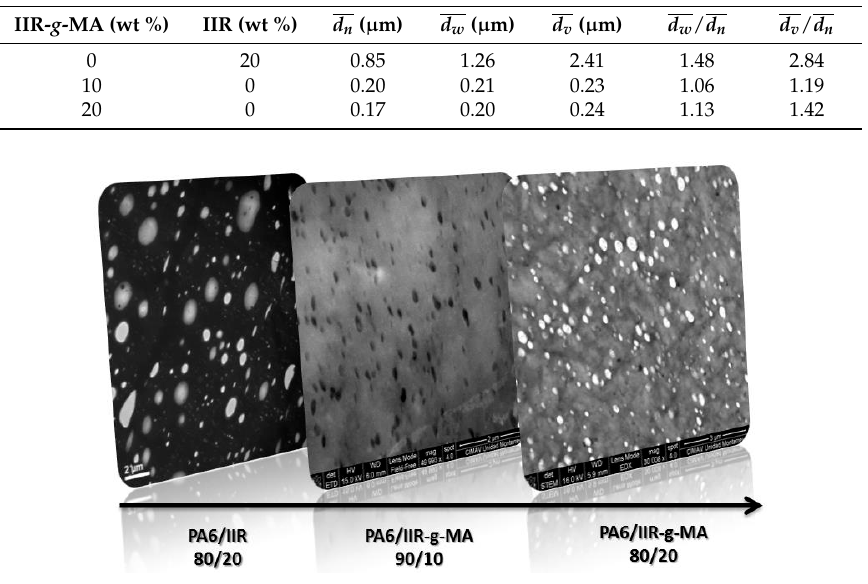
Figure 6. TEM photomicrographs of binary blends of PA-6/IIR (80/20 wt %), PA-6/IIR- g -MA (90/10 wt % and 80/20 wt %), prepared in a twin-screw extruder. Magnification used was 30,000 × , 50,000 × , and 30,000 × respectively. The polyamide phase is stained dark with phosphotungstic acid. The